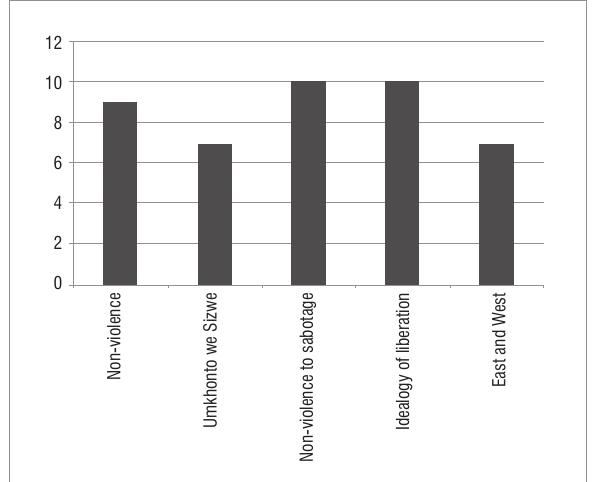
Figure 2: Number of occurrences of themes supporting efficacy.